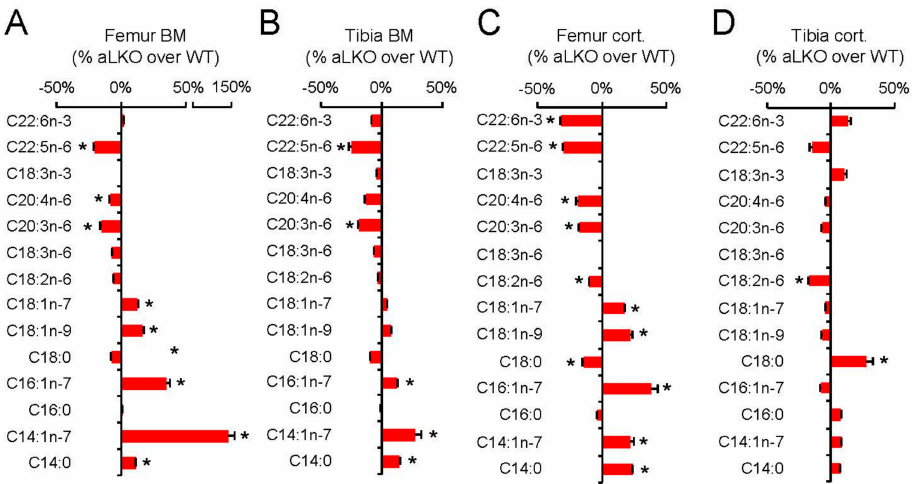
Figure 5. Role of LPL for bone fatty acid composition. Change in relative fatty acid composition determined by gas chromatography from: ( A ) Femur BM; ( B ) Tibia BM; ( C ) Femur cort.; and ( D ) Tibia cort. isolated from 12-week-old female aLKO mice and wild-type controls. Mean ± SEM; n = 5 per group. LPL: lipoprotein lipase; BM: bone marrow; aLKO: adipocyte-specific lipoprotein lipase knock-out (* p <